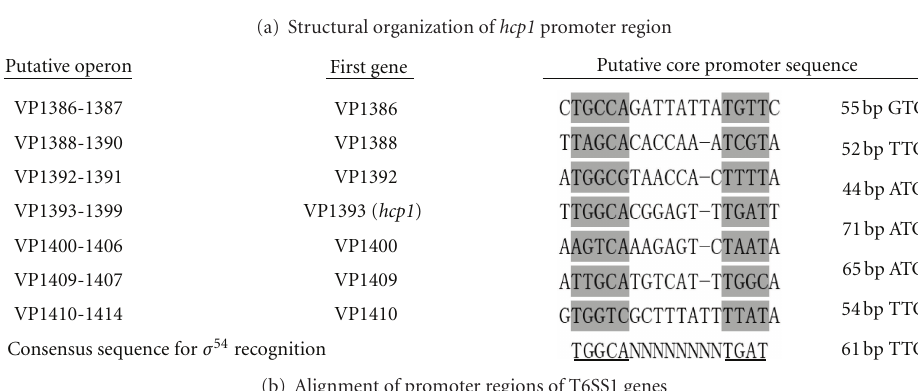
Figure 5: Organization of promoter-proximal regions. DNA sequence was derived from V. parahaemolyticus RIMD 2210633 [7]. Shown within the hcp1 upstream region (a) were translation and transcription starts, SD sequences, and − 10/ − 12 and − 35/ − 24 core promoter elements. The T6SS1 gene cluster forms 7 putative operons, and the upstream regions of the first genes of these operons were aligned for predicting the − 10 and − 24 elements